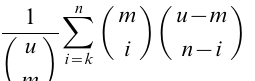
Table S2 A list of genes either down- or up-regulated in swm1